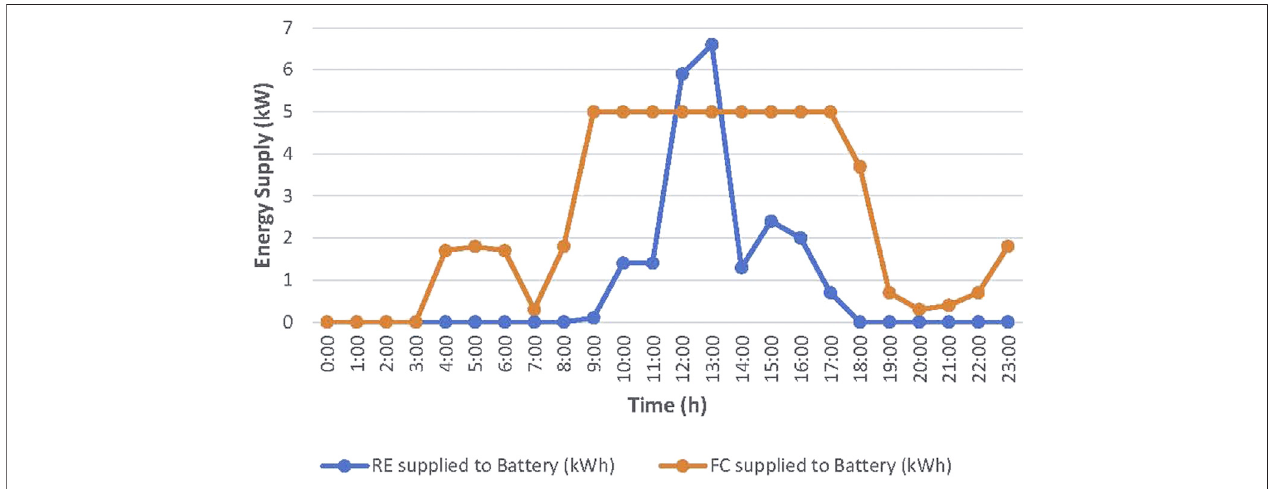
FIGURE 7 | Energy Supplied by the Renewable Energy and Fuel Cell to Charge the Battery in Day 1